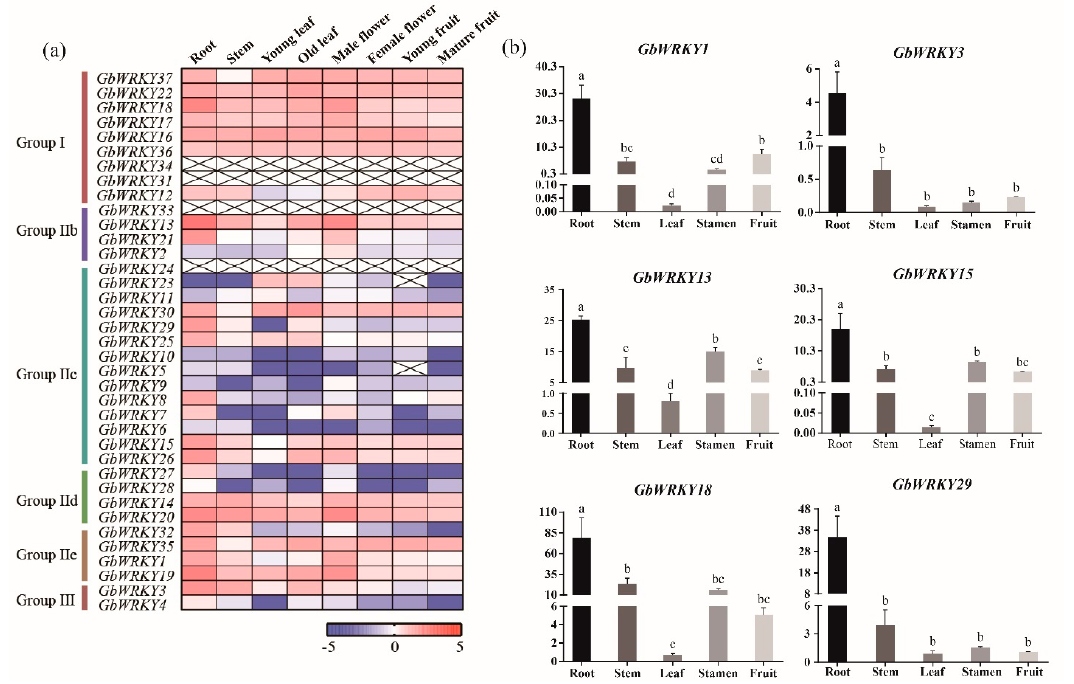
Figure 4. Expression profiles of GbWRKY genes in different G. biloba tissues from RNA − Seq and DGE data ( a ) and qRT − PCR verification ( b ).